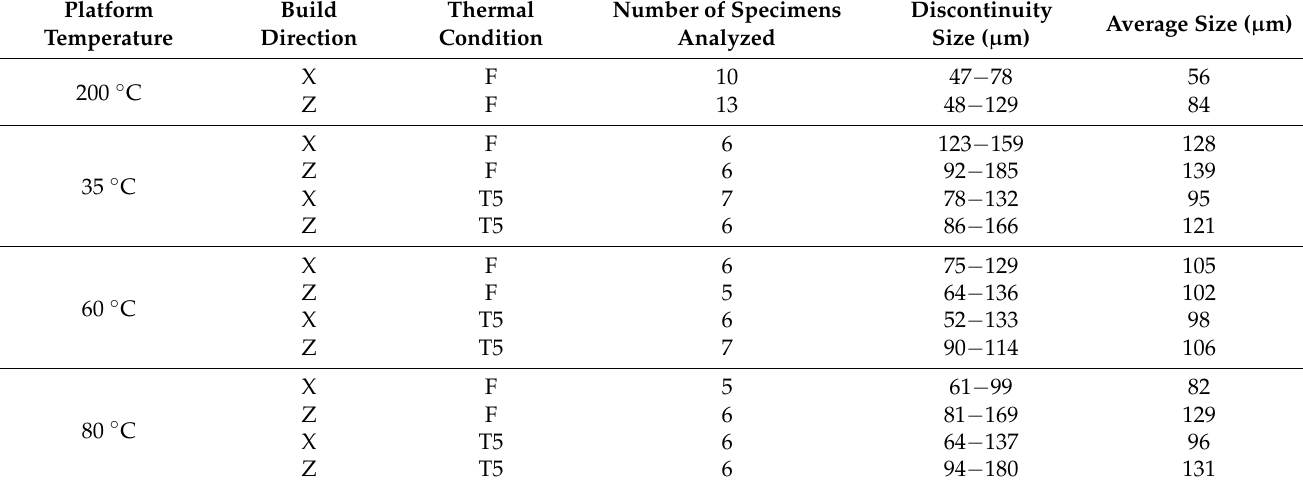
Table 4. Summary of features and their characteristics observed at crack initiation